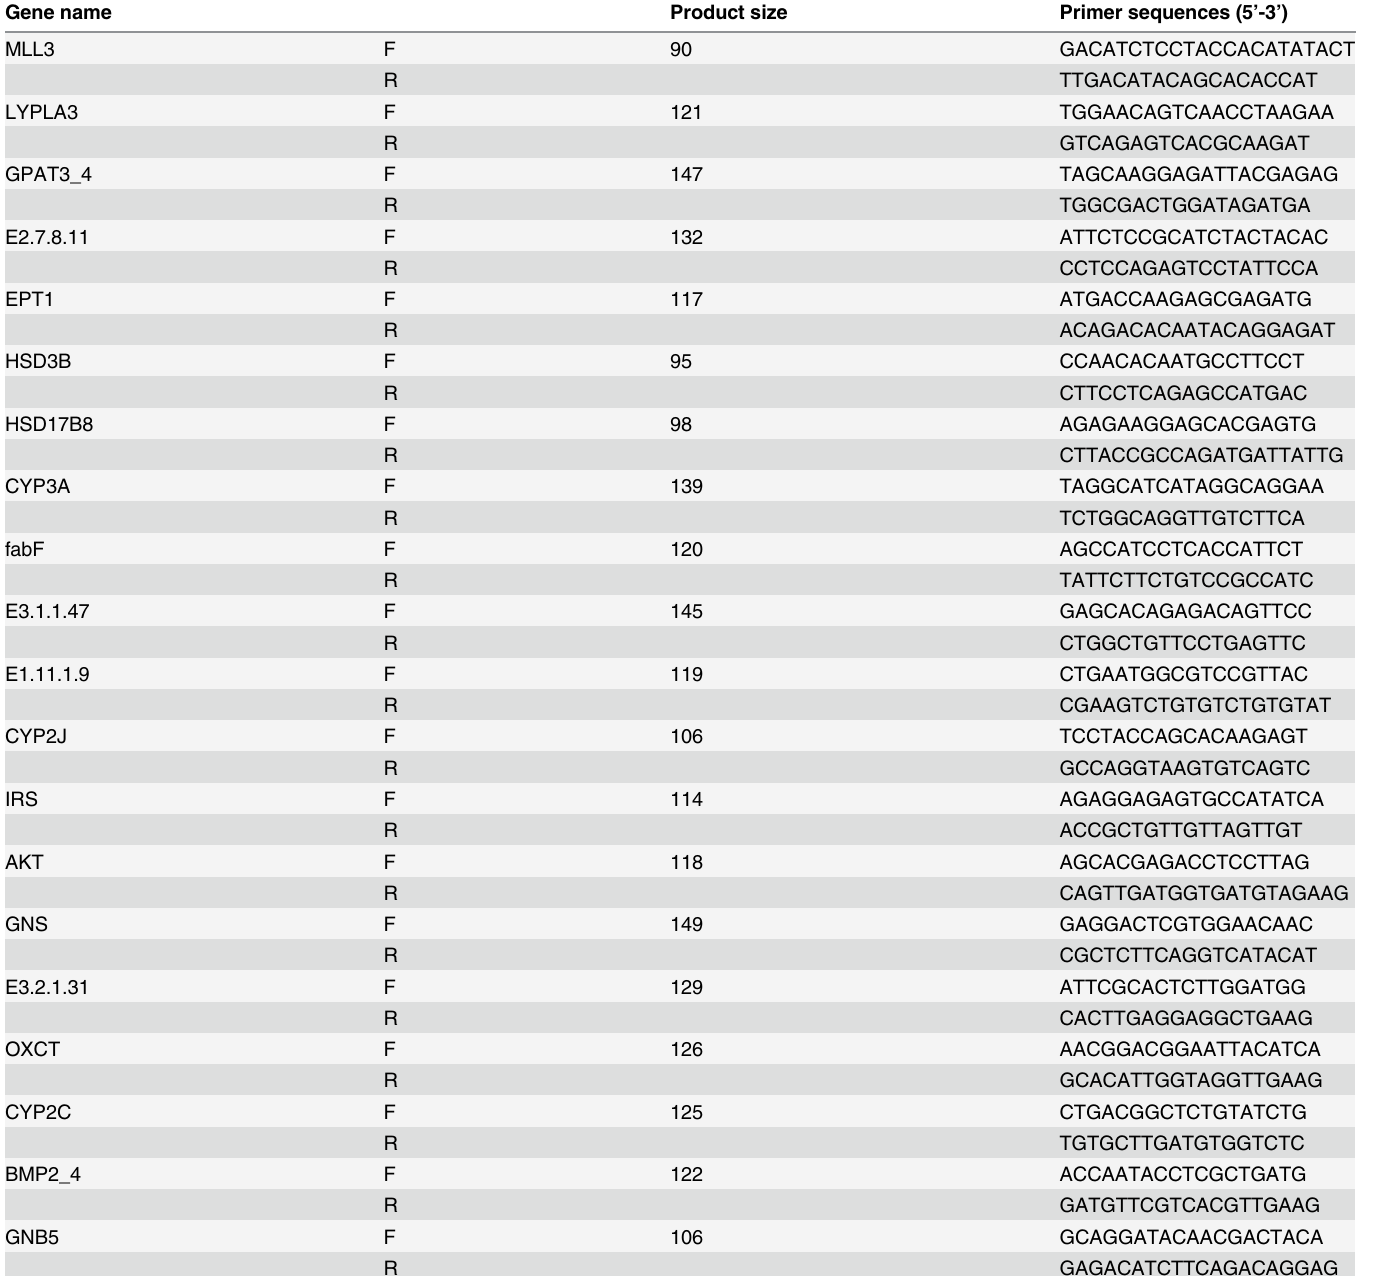
Table 7. Primers used for the qPCR